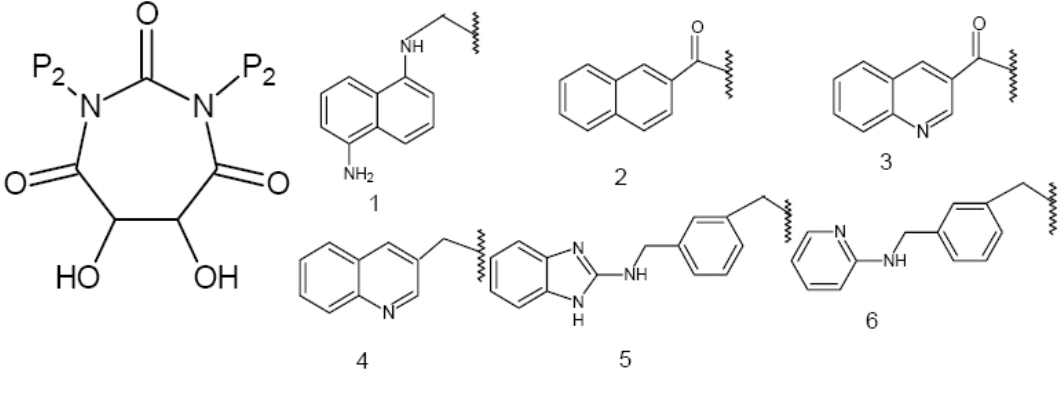
Fig. 2 Structures of new trione cyclic urea inhibitors with P 2